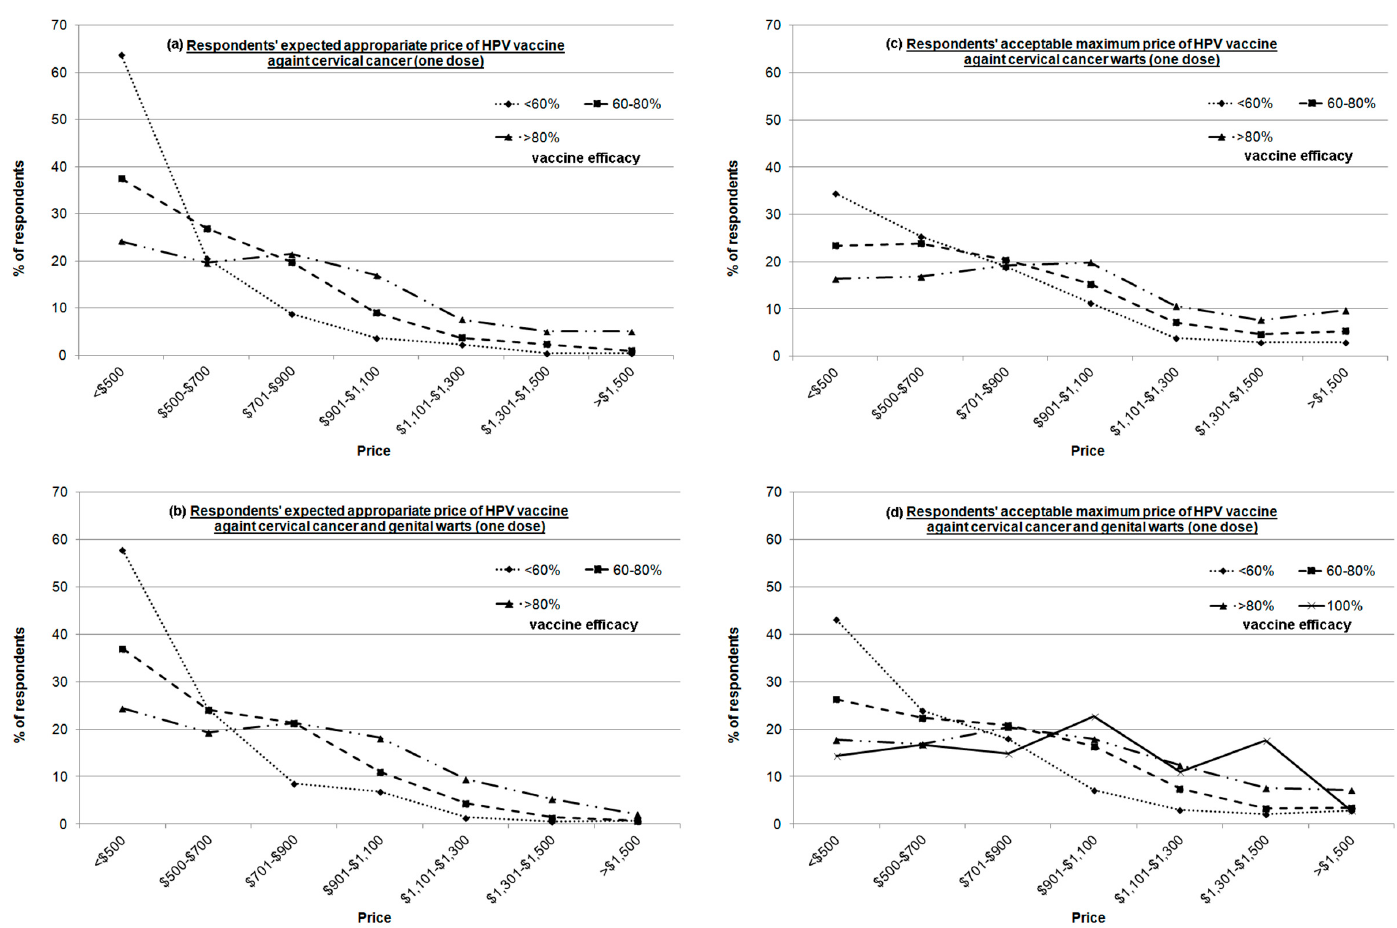
Figure 1. Respondents’ expectations of the appropriate and maximum prices for HPV vaccine. ( a ) Respondents’ expectations of the appropriate price for the HPV vaccine against cervical cancer; ( b ) Respondents’ expectations of the appropriate price for the HPV vaccine against cervical cancer and genital warts. ( c ) Respondents’ acceptable maximum price for the HPV vaccine against cervical cancer; ( d ) Respondents’ acceptable maximum price for the HPV vaccine against cervical cancer and genital warts.